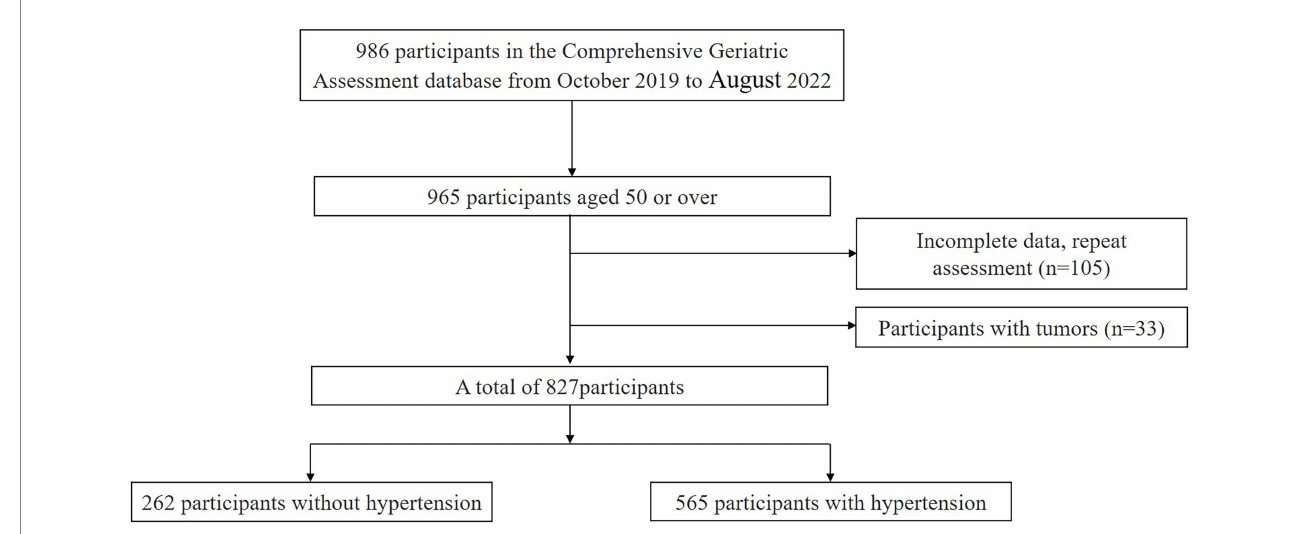
FIGURE 1 Participant inclusion flow